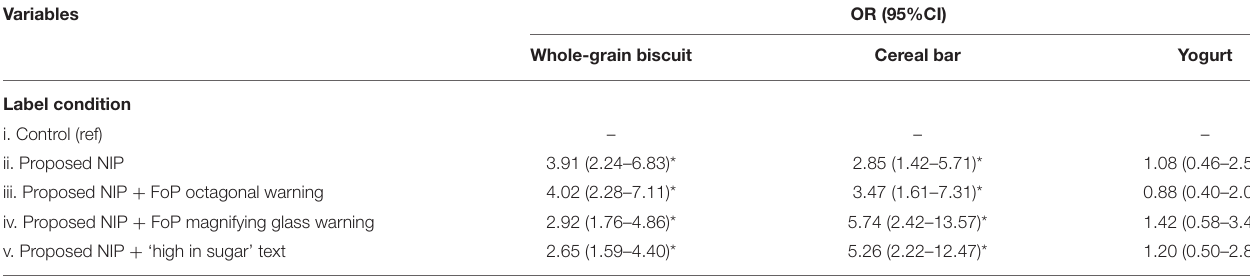
TABLE 3 | Odds ratios (OR) and 95% confidence intervals (CI) for primary (understanding) outcome ( n = 1,277).